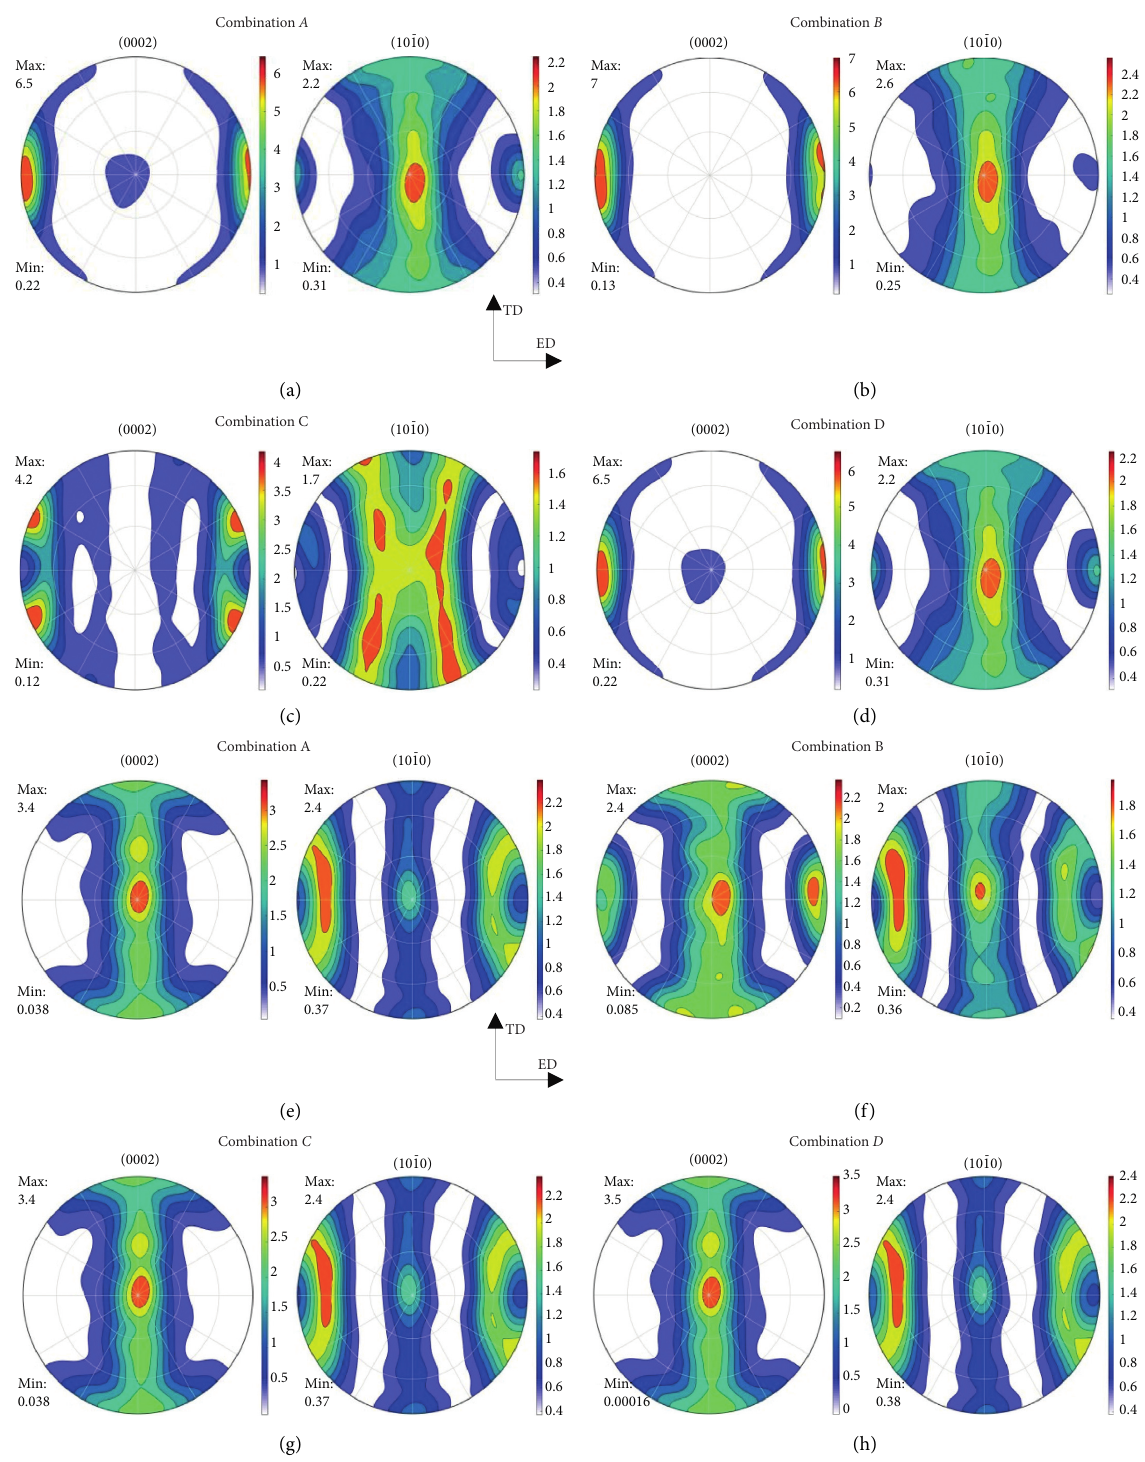
Figure 7: Predicted texture under (a-d) axial compression and (e-h) axial tension at a strain of 0.15 with different combinations of deformation